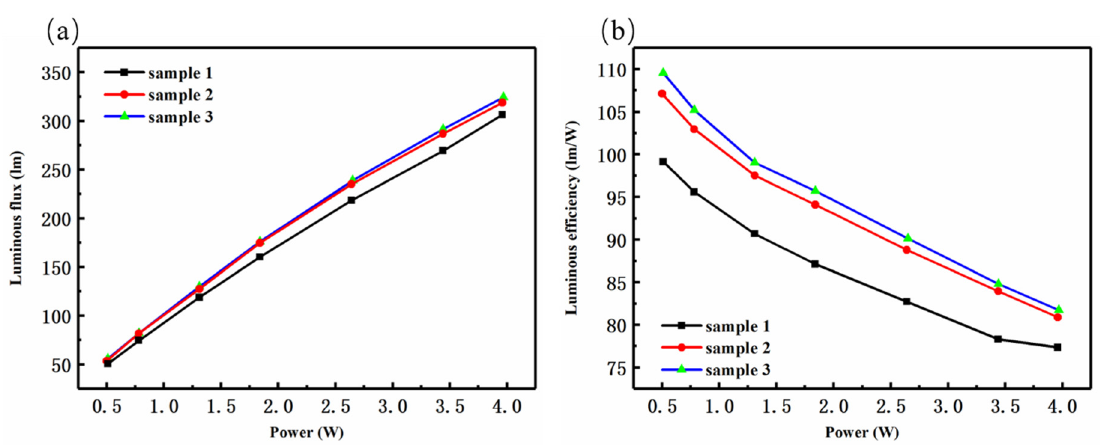
Figure 4. Luminous flux ( a ) and luminous efficiency ( b ) of the three different filament arrangements under different powers.